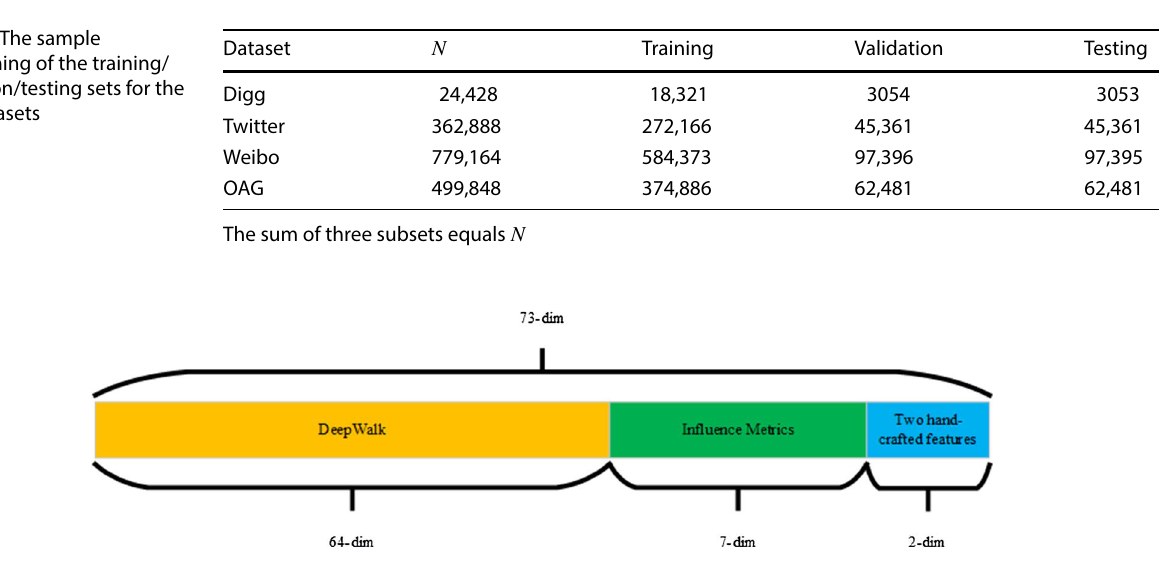
Fig. 6 The node representation consists of three parts: pretrained 64-dim DeepWalk embedding; customized 7-dim social influence metrics, including coreness, eigenvector centrality, clustering coefficient, etc; two hand-crafted features, one indicates the behavior status ( 0 ∕ 1 ) , the other indicates whether the user is the ego-user ( 0 ∕ 1